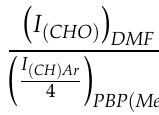
Figure S5: DTA/TGA curves and the evolution of gases for ICR-9Cryst. Figure S6: DTA/TGA curves and the evolution of gases for ICR-9A. Figure S7: DTA/TGA curves and the evolution of gases for ICR-9B. Figure S8: Assignment of 31 P peaks in the solid state NMR spectra. Figure S9: FTIR spectra of ICR-9Cryst, ICR-9A, and ICR-9B. Table S1. Crystallographic details of ICR-9. Author Contributions: Conceptualization, J.D.; investigation, J.R., D.B., L.K., P.B, and J.H.; writing—original draft preparation, J.D. and J.R.; writing—review and editing, K.L. and J.B.; project administration, J.D. Funding: This research was funded by the Czech Science Foundation, grant number 18-12925S. Acknowledgments: The authors are grateful to the working group Interactions of Inorganic Clusters, Cages, and Containers with Light within the AV21 Strategy of the Czech Academy of Science, Petr Bezdička for the